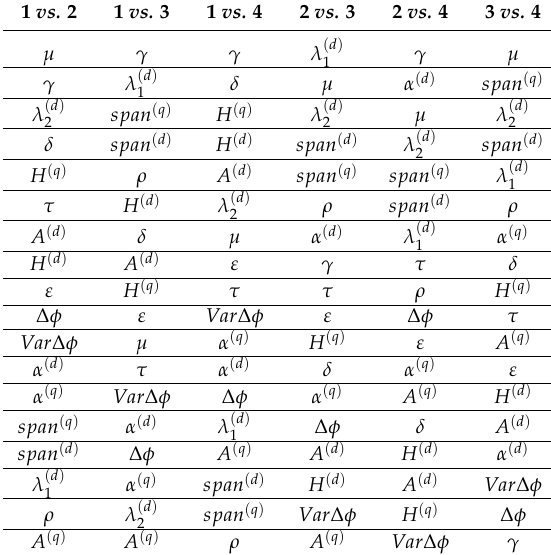
Table 5. RS-2, 2014/04/23: Two-class-relevance in descending order for different pairs of classes. Class indices are: 1: OW, 2: YI, 3: SFYI, 4: RFYMYI. 1 vs. 2 1 vs. 3 1 vs. 4 2 vs. 3 2 vs. 4 3 vs.